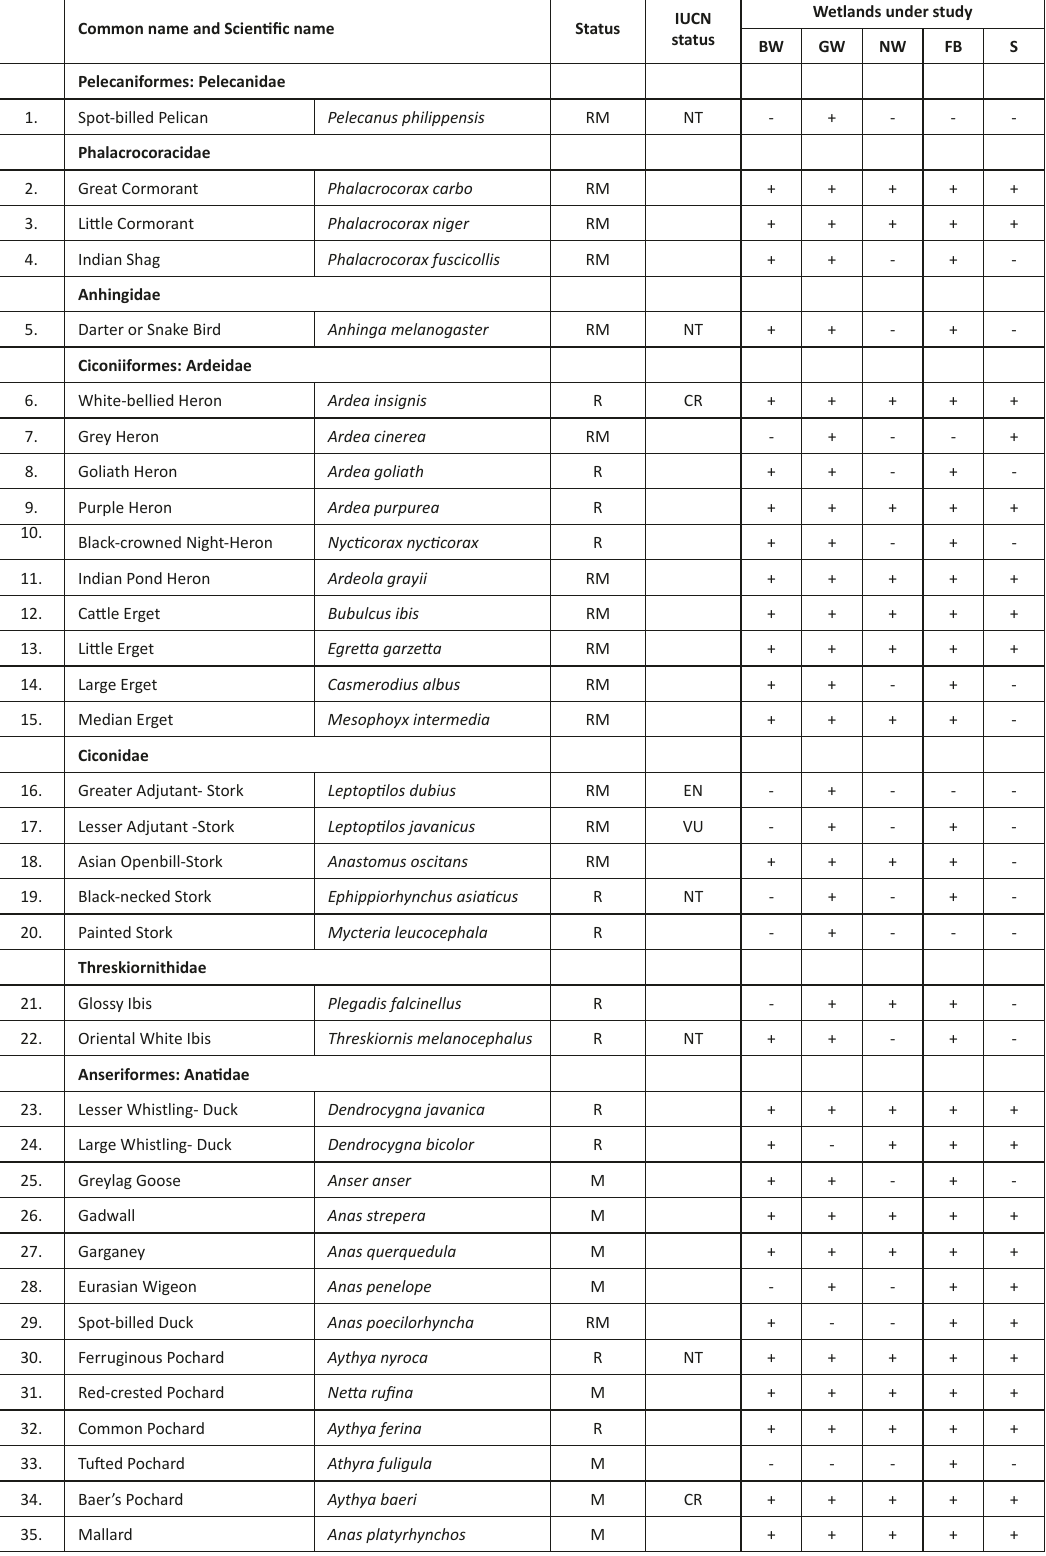
Table 2. List of avifauna recorded in five wetlands of Diara and Barind region of Maldah District. Common name and Scientific